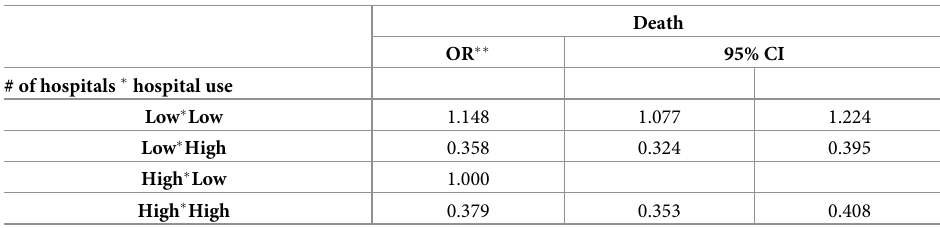
Table 4. Adjusted combined effect on death.